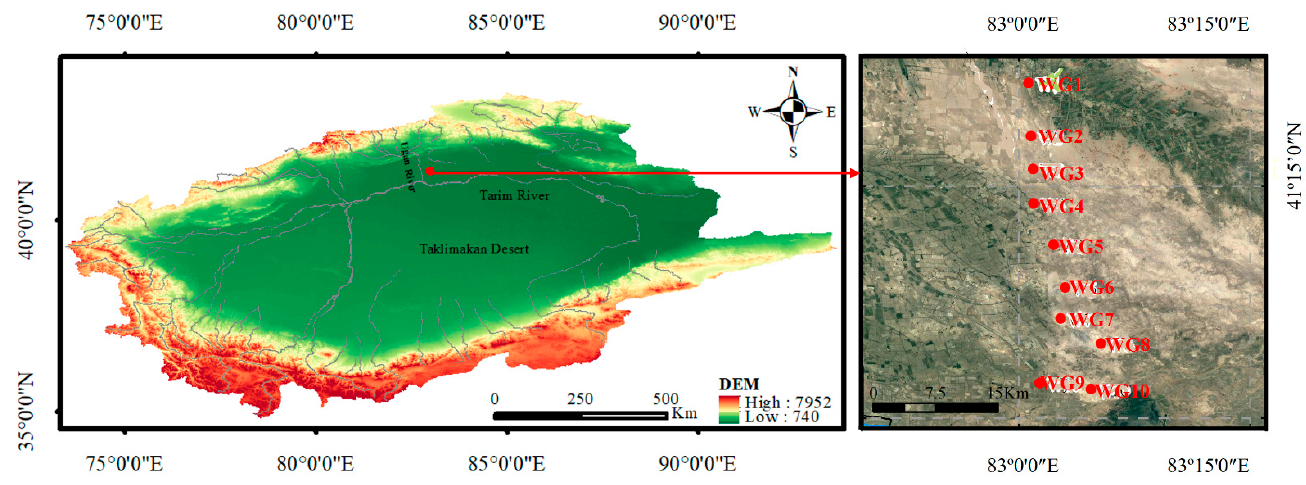
Figure 1. WG1, WG2, WG3, etc. are the monitoring wells which were set up along the lower reaches of the Ugan